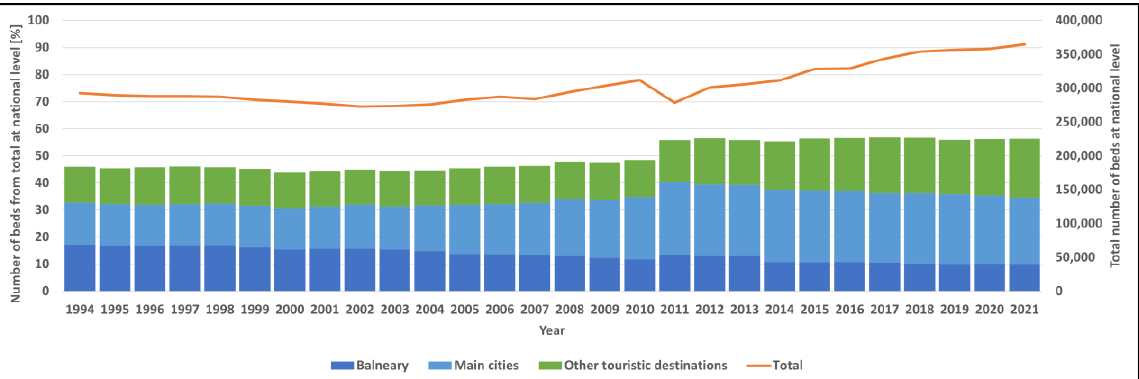
Figure 3. Percentage of the number of beds in accommodation units in various touristic destination types in Romania (bars), from the total number of beds at the national level (line) for 1994 – 2021. (source: processed data from NIS www.insse.ro, accessed on 29 June 2022).